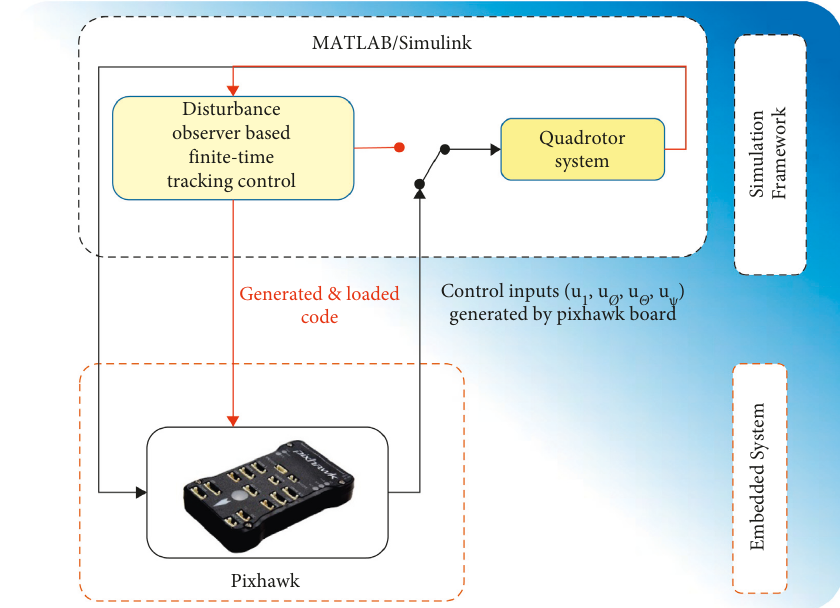
Figure 3: Flow chart of the PIL implementation process.